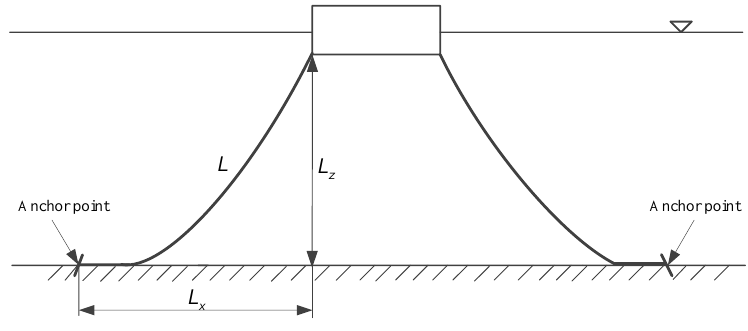
Figure 1. Sketch of a catenary mooring line model.